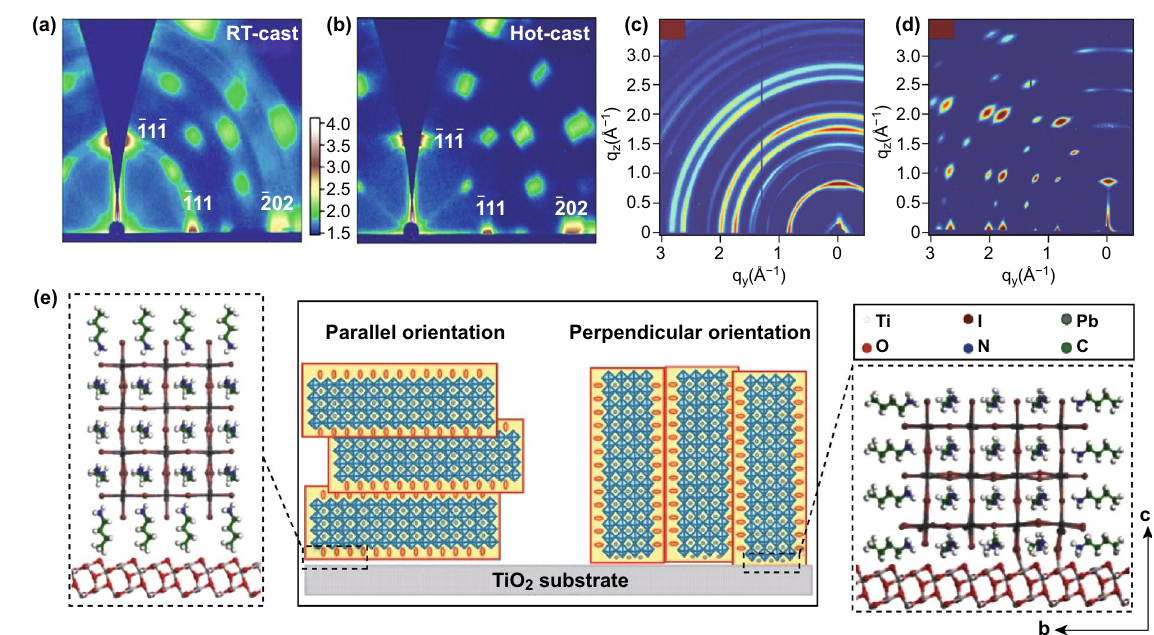
Fig. 5 2D GIWAXS plots of BA 2 MA 3 Pb 4 I 13 films processed using a RT casting and b hot casting [86]. Copyright © 2019 Elsevier Ltd. c GIWAXS data of the hot-cast films from DMF and d from the optimized 3:1 DMF: DMSO mixed solvent [17]. Copyright © 2017 WILEY-VCH Verlag GmbH & Co. KGaA, Weinheim. e Titanium oxide/(BA) 2 (MA) 3 Pb 4 I 13 interface (optimized structures) for the parallel orientation (left) and perpendicular orientation (right) conditions [87]. Copyright © 2018 WILEY-VCH Verlag GmbH & Co. KGaA,